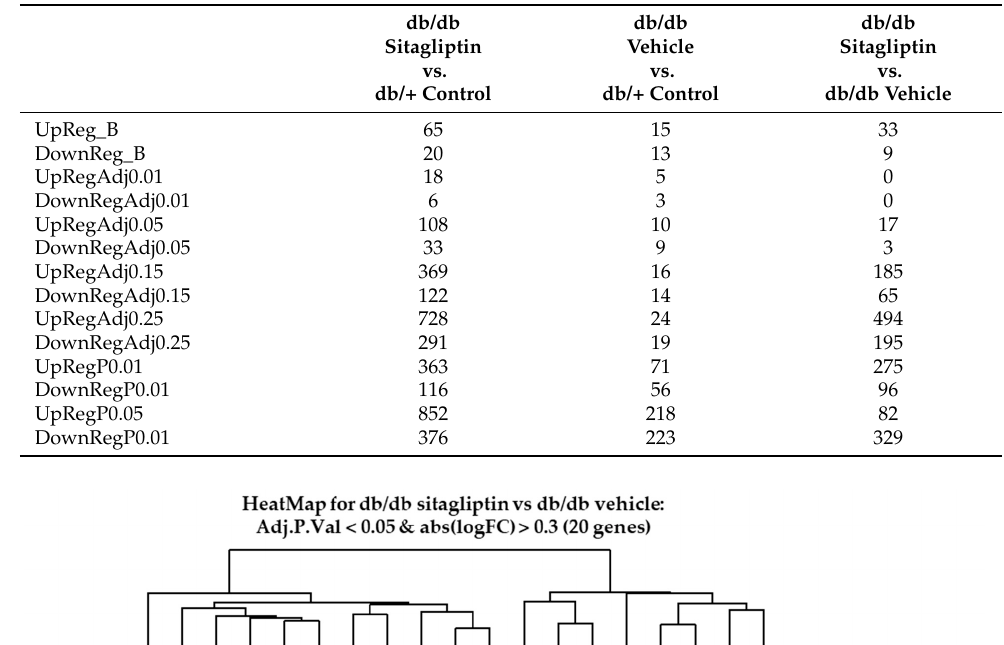
Table 1. Multiple comparisons of DEGs between groups. Summary table of the number of DEGs acquired for each comparison at distinct significance thresholds (green: db/db sitagliptin vs. db/+ control; red: db/db vehicle vs. db/+ control; blue: db/db sitagliptin vs. db/db vehicle) ( n = 10).